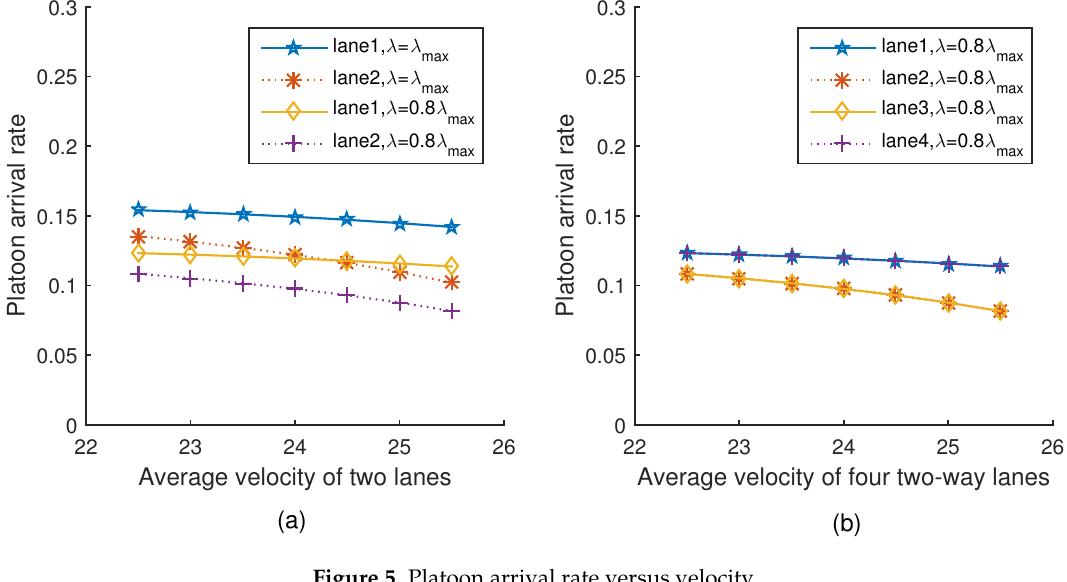
Figure 5. Platoon arrival rate versus